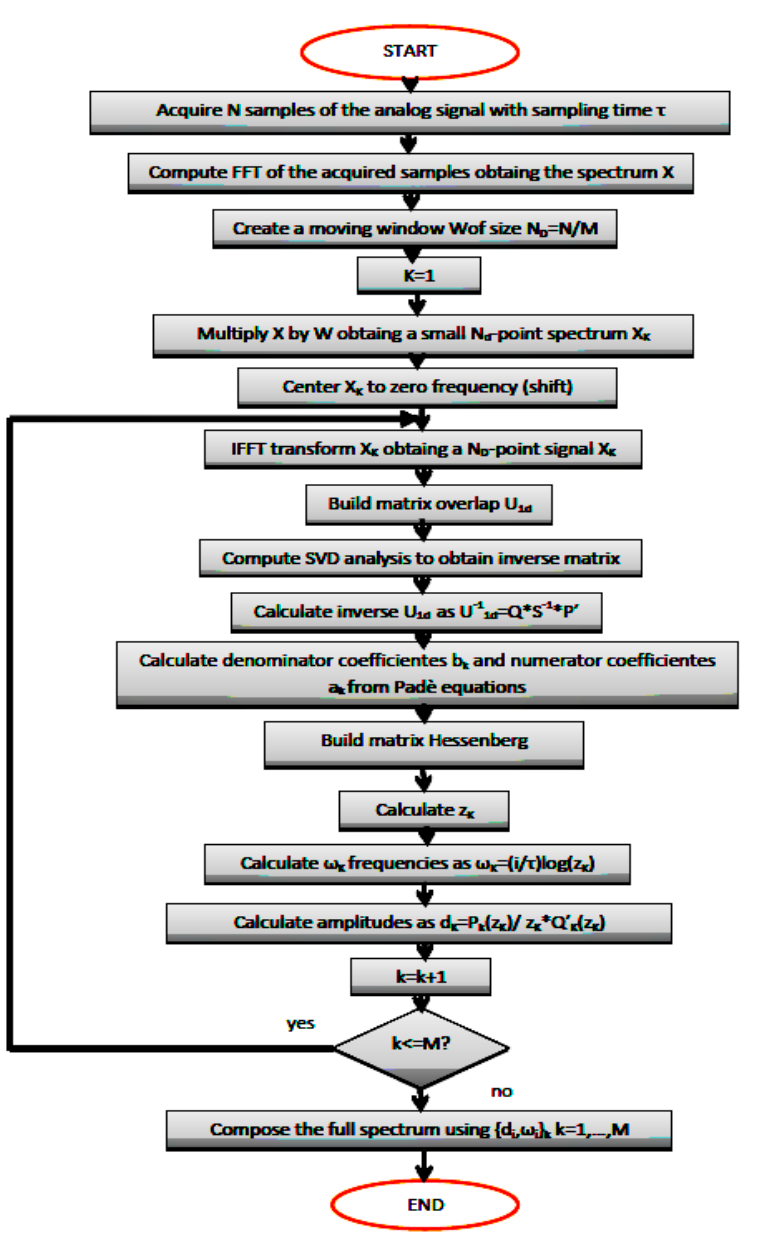
Figure 5. Concise DPA procedure for processing signal from pressure transducer.